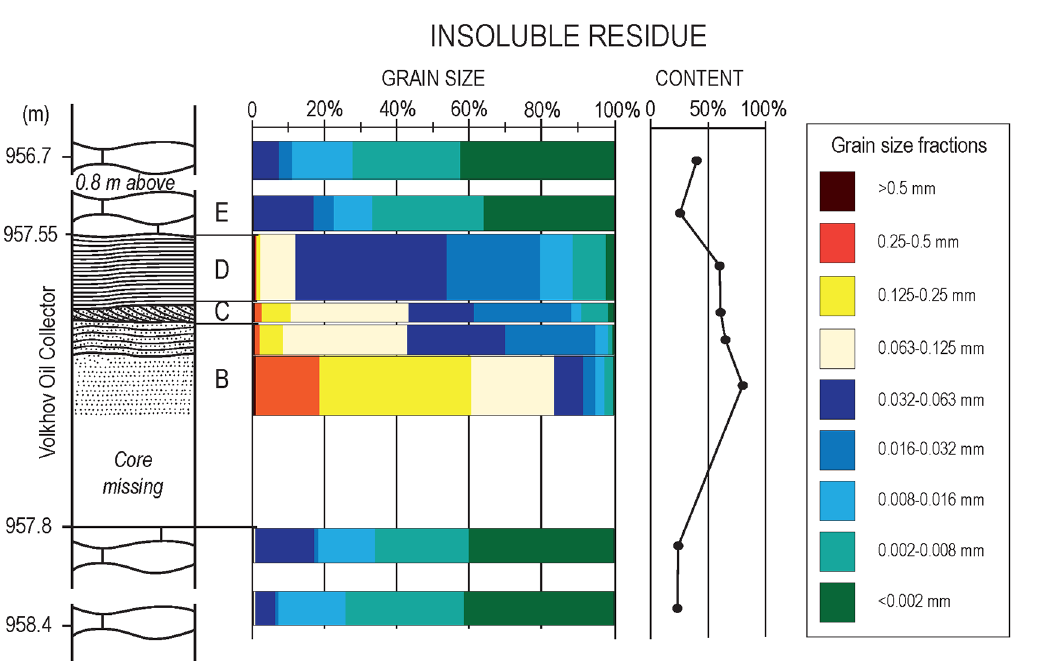
Fig. 3. Grain size distribution and content of insoluble material of the Volkhov Oil Collector in the Vergale-50 core section. Note the gradual decrease in both the grain size and content of siliciclastic material from the bottom to the top of the bed.